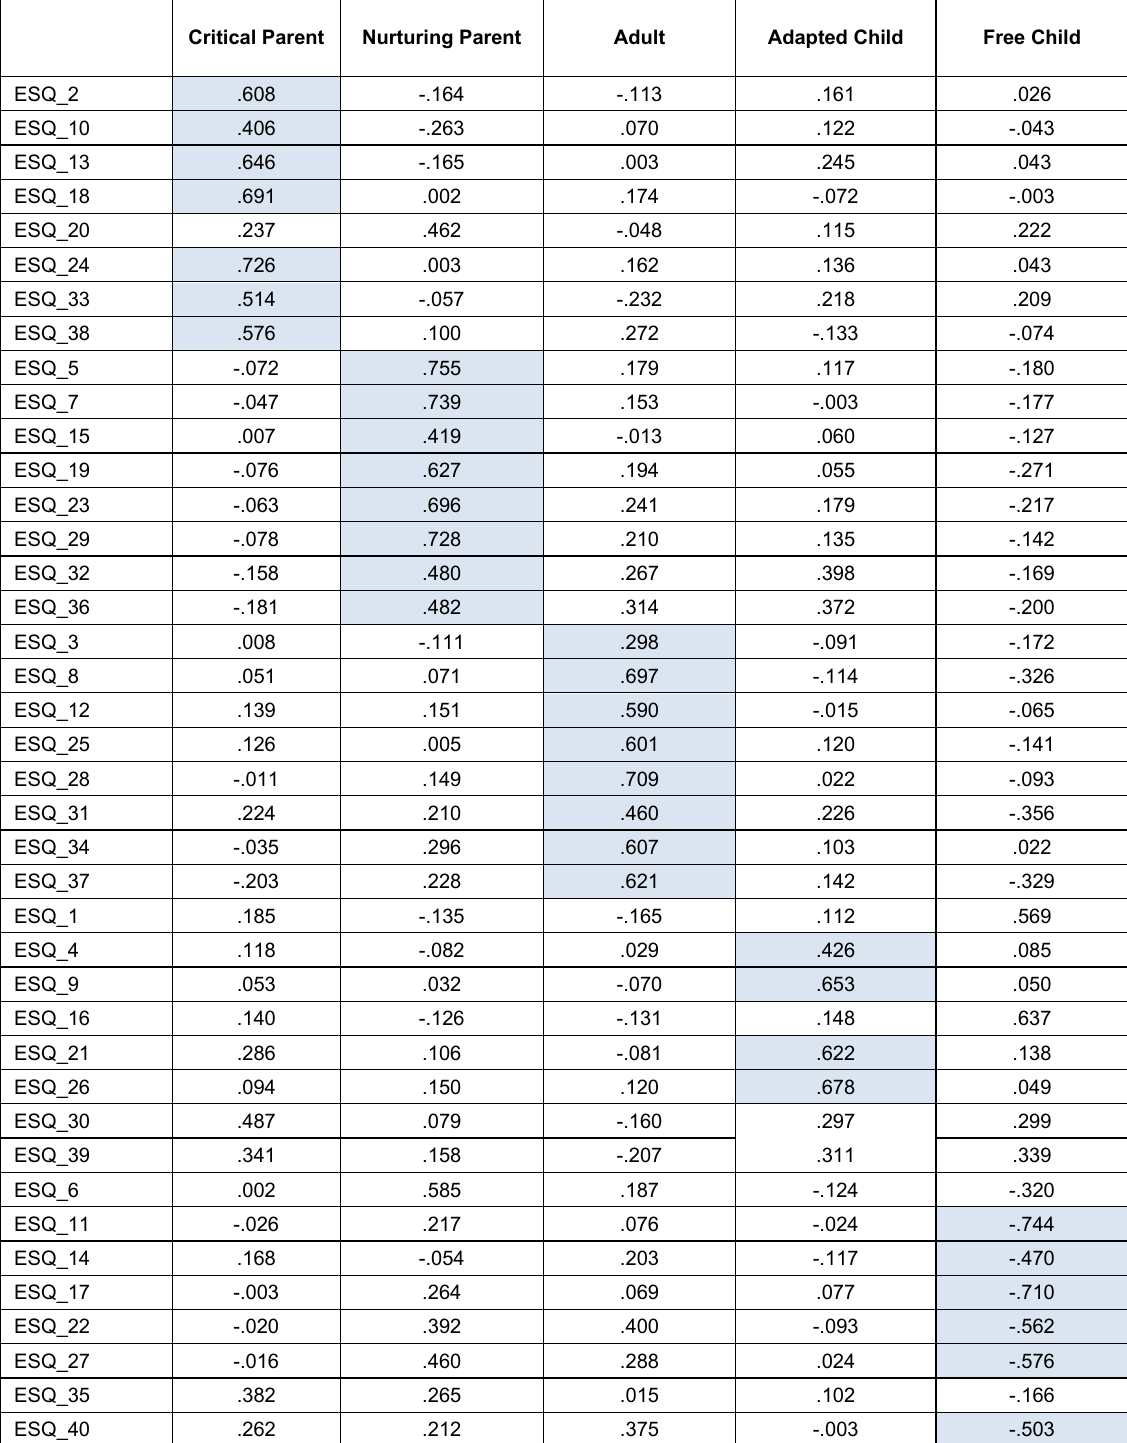
Table 1: Structure Matrix of the Ego State Questionnaire-Revised dimensions for the five dimensions (N =